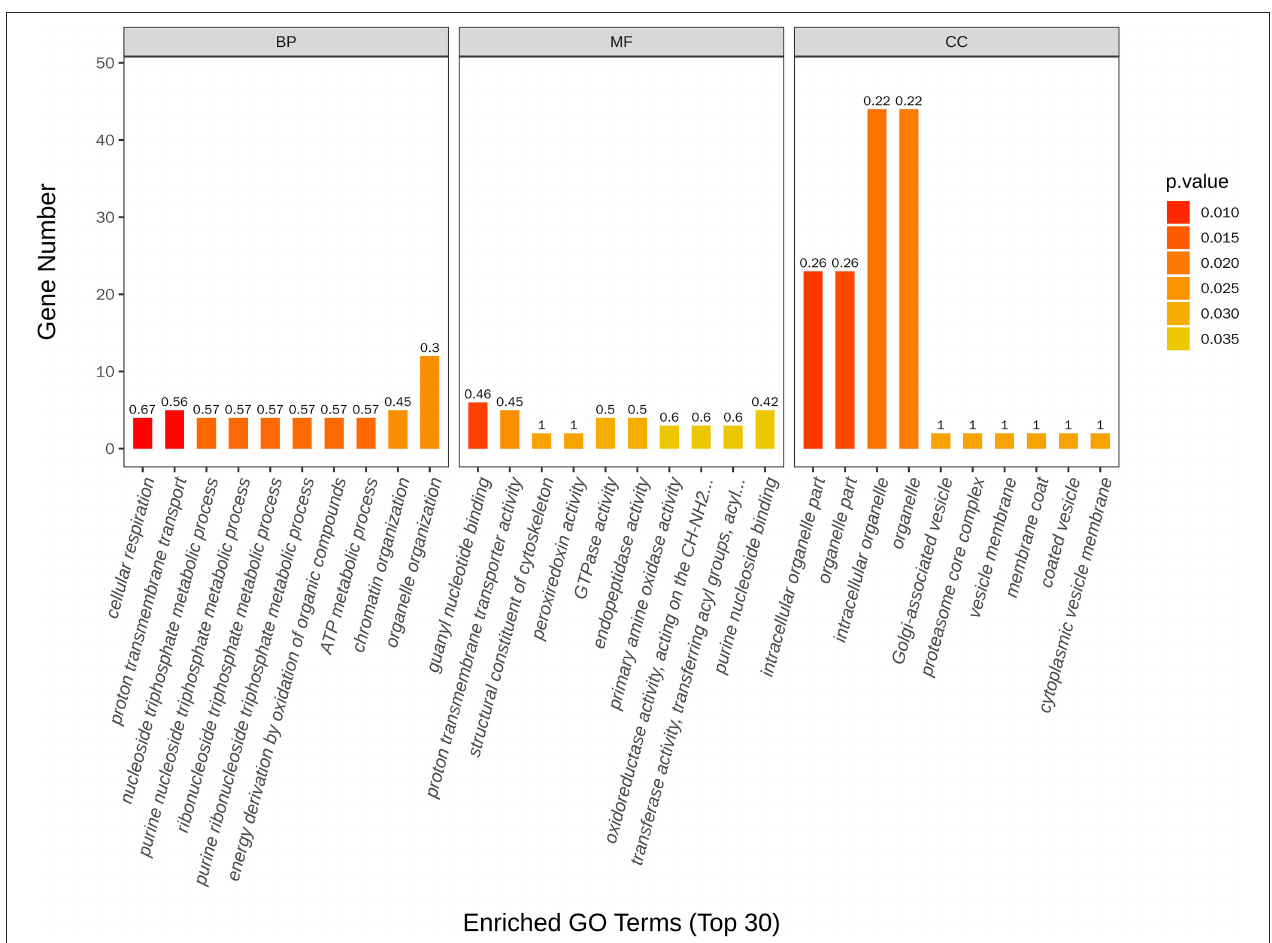
FIGURE 7 | Top 30 GO terms of differentially expressed genes between control and nanoemulsion treatment.